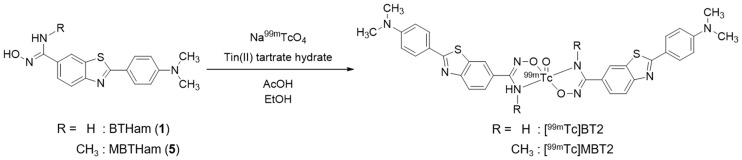
Radiosynthesis of [99mTc]BT2 and [99mTc]MBT2.